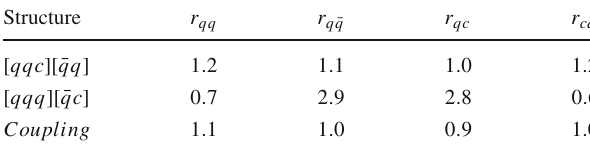
Table 7 The RMS distances of the qqq ¯ qc pentaquark system